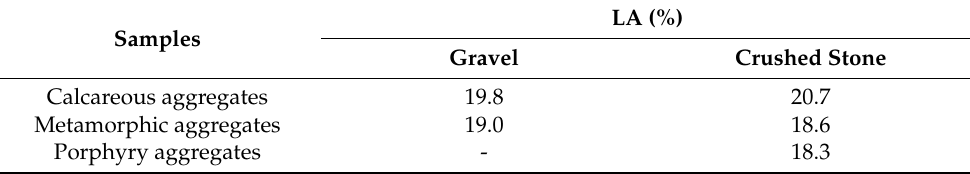
Table 11. Los Angeles coefficients (LA, expressed in percentage) of the aggregates analyzed